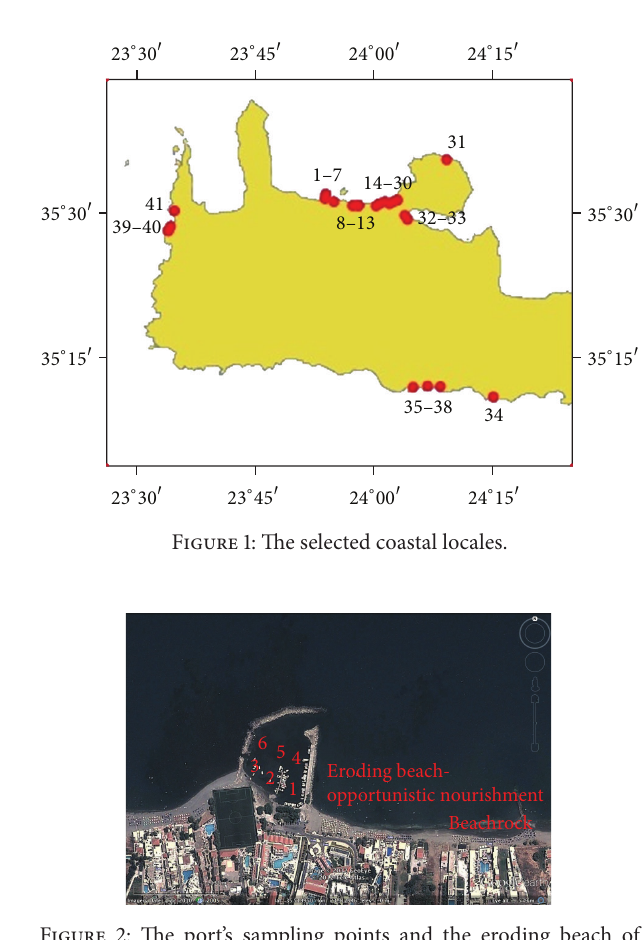
Figure 2: The port’s sampling points and the eroding beach of Platanias